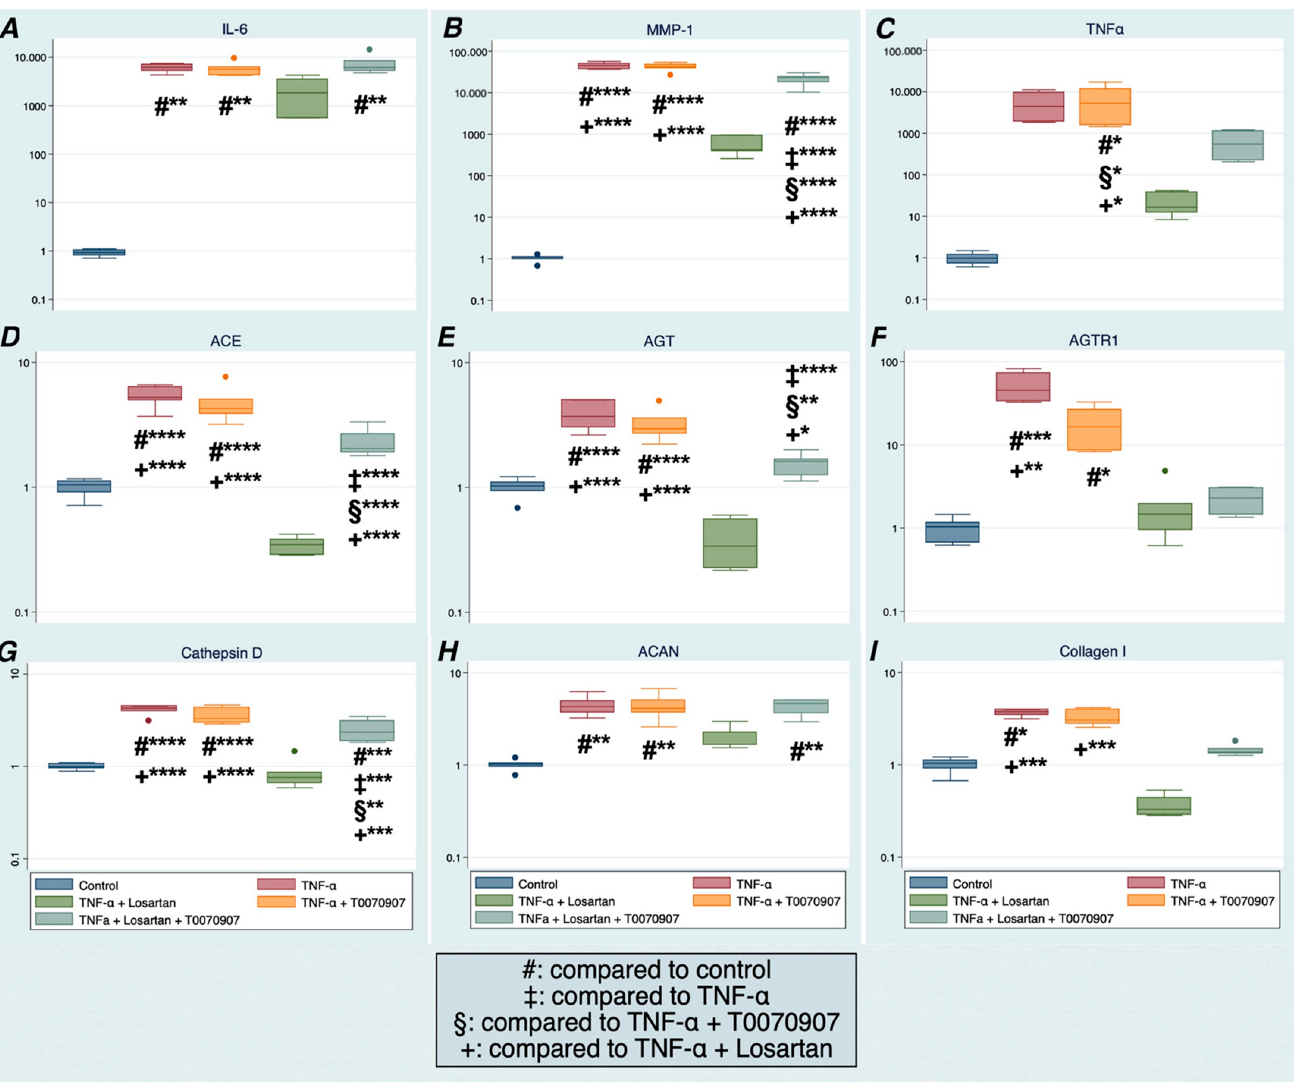
Figure 4. Influence of the PPAR γ pathway on losartan-induced gene expression changes of inflammatory and tissue degeneration markers ( A – C ), tRAS markers ( D – G ), and cell phenotype markers ( H , I ) in human NP cells after 24 h of exposure. Gene expression was normalized to Day 0 (baseline) values. Data from two donors assessed in triplicate are shown ( n = 6); * p < 0.05; ** p < 0.01; *** p < 0.001; **** p < 0.0001.